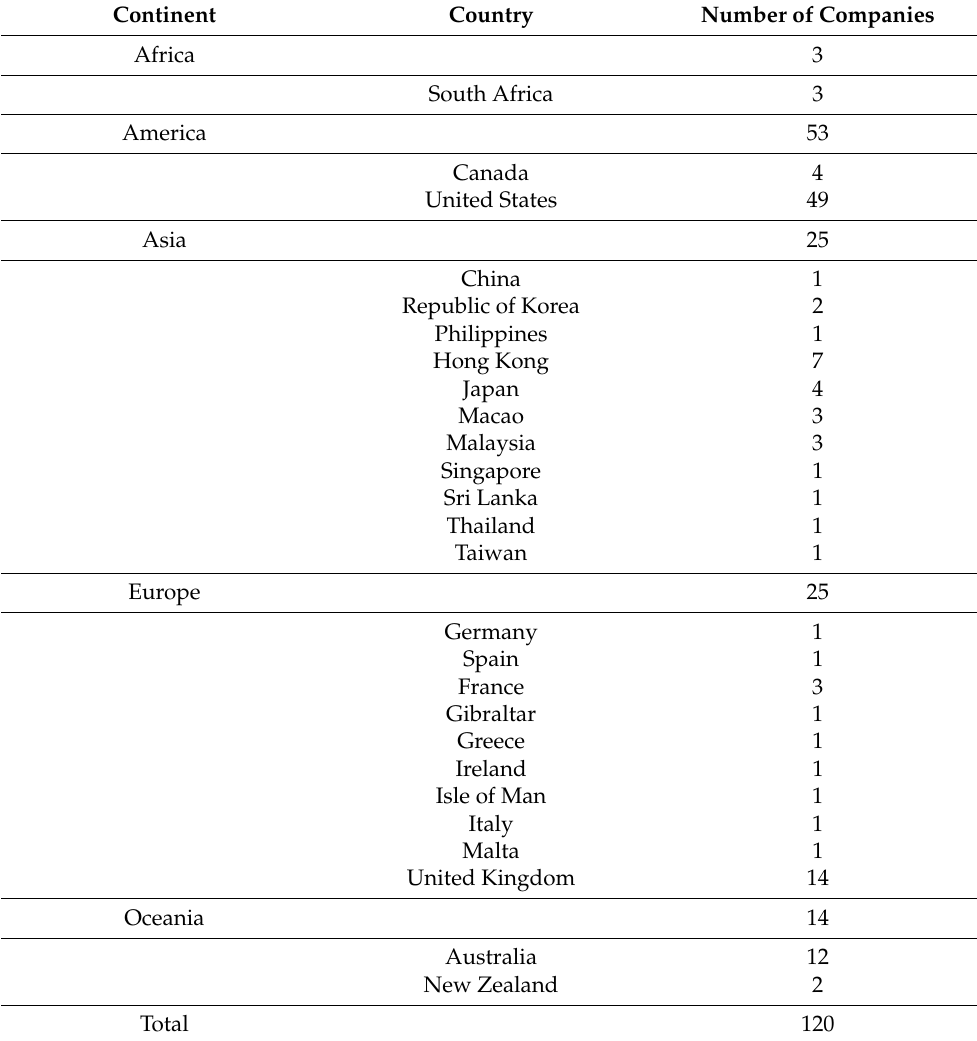
Table 2. Distribution of the sampled companies by continent and country. Continent